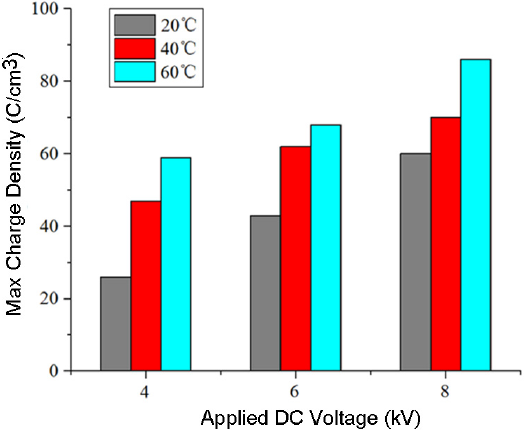
Figure 4. Max charge density on the negative electrode under different DC voltages and temperatures (three layers, about 130 μ m in total thickness).